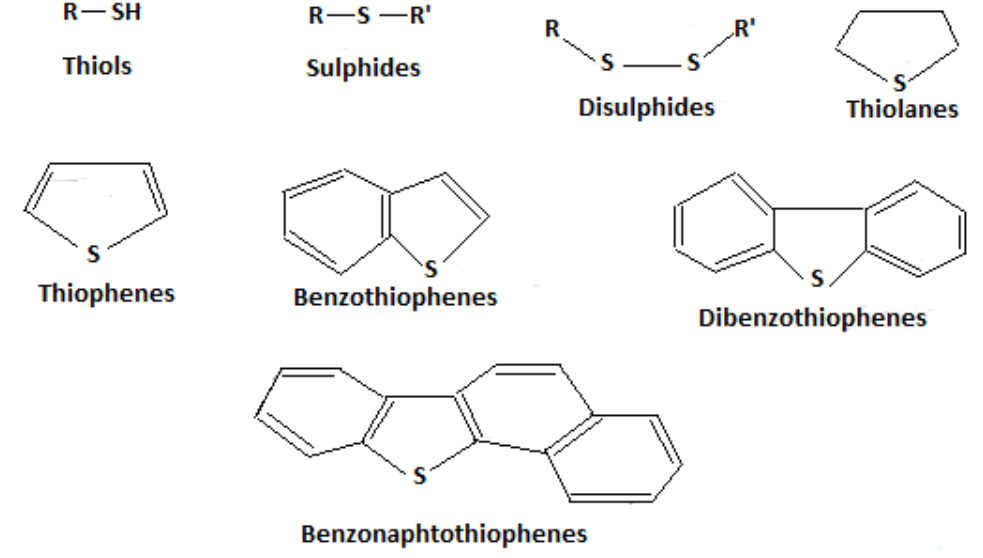
Figure 1. Chemical structure of organic sulphur compounds present in crude oils. Adapted from [72].